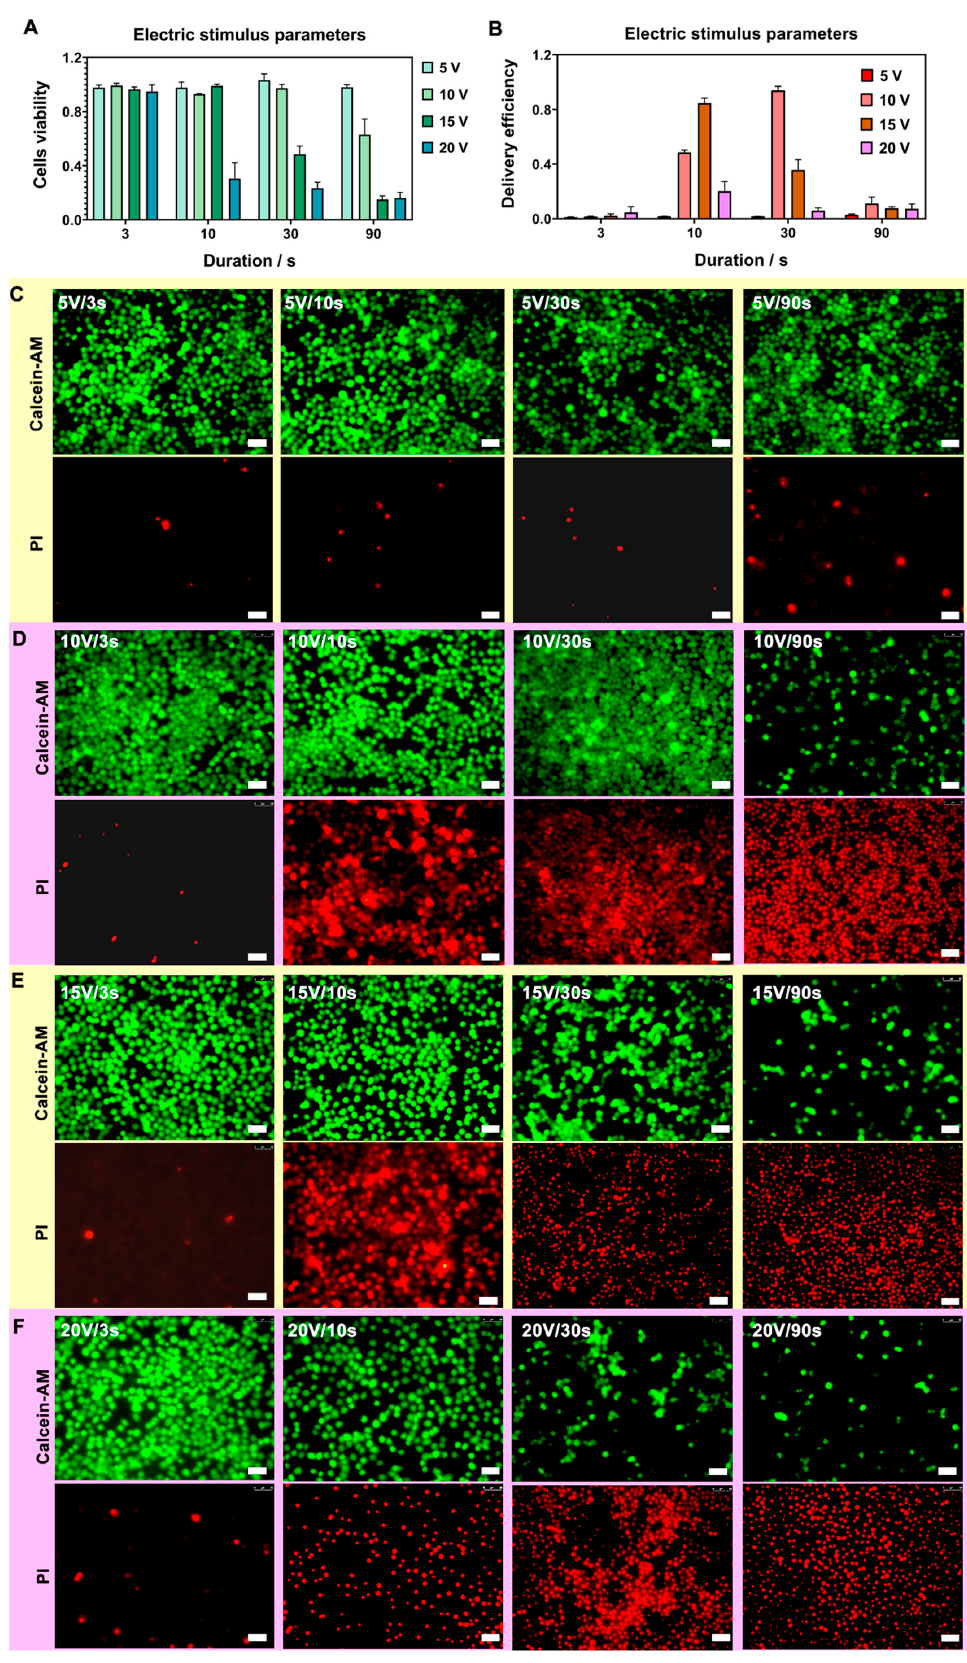
Figure 3. ( A,B ), Statistical analysis of nanostraw-electroporation vitality ( A ) and PI delivery